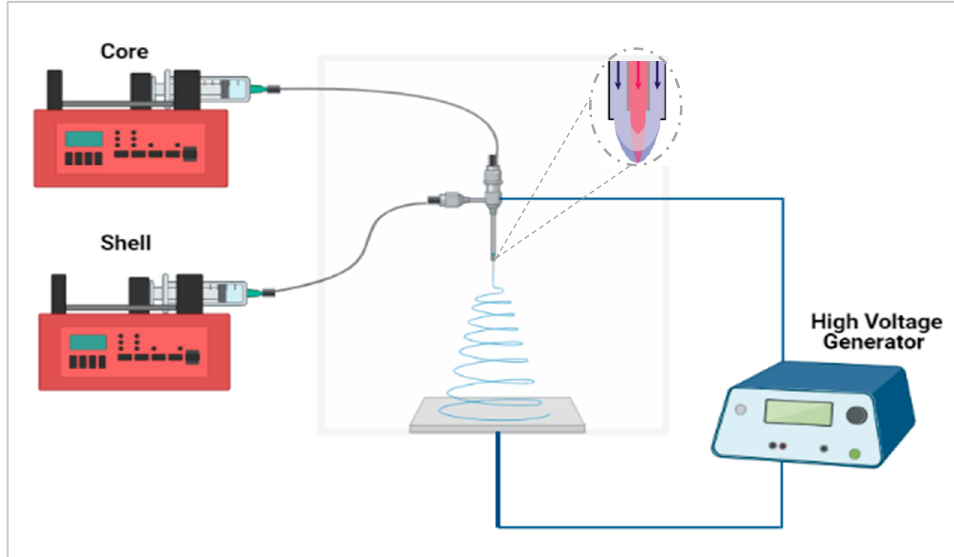
Figure 1. Co-axial electrospinning setup schematic. Created with https://biorender.com/; accessed on 1 June 2021.